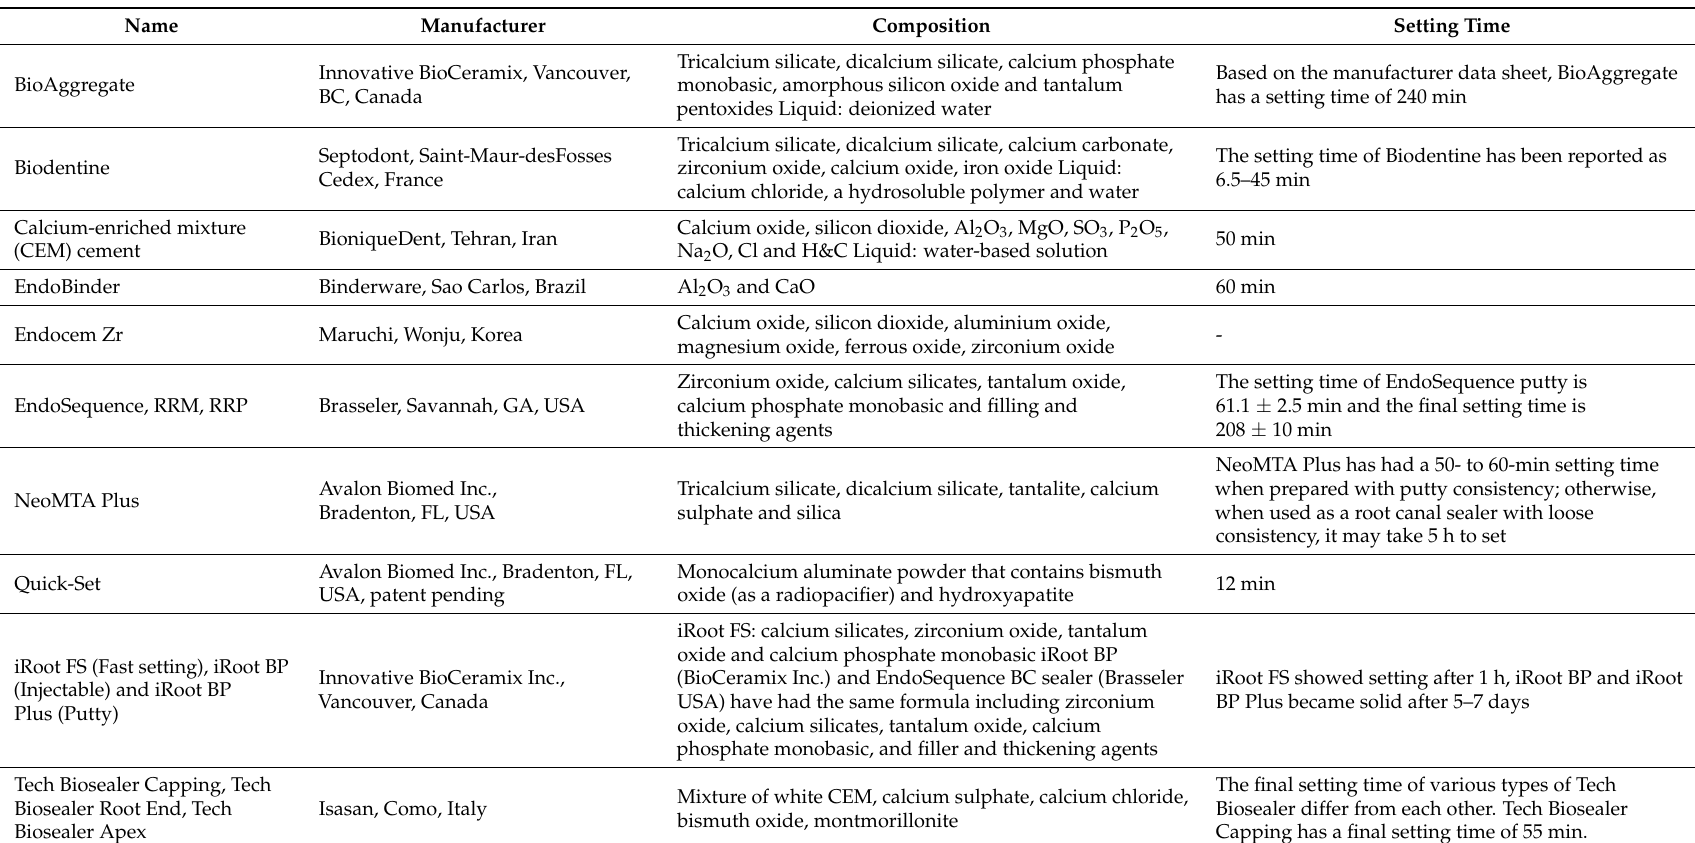
Table 2. Bioactive endodontic cements for root